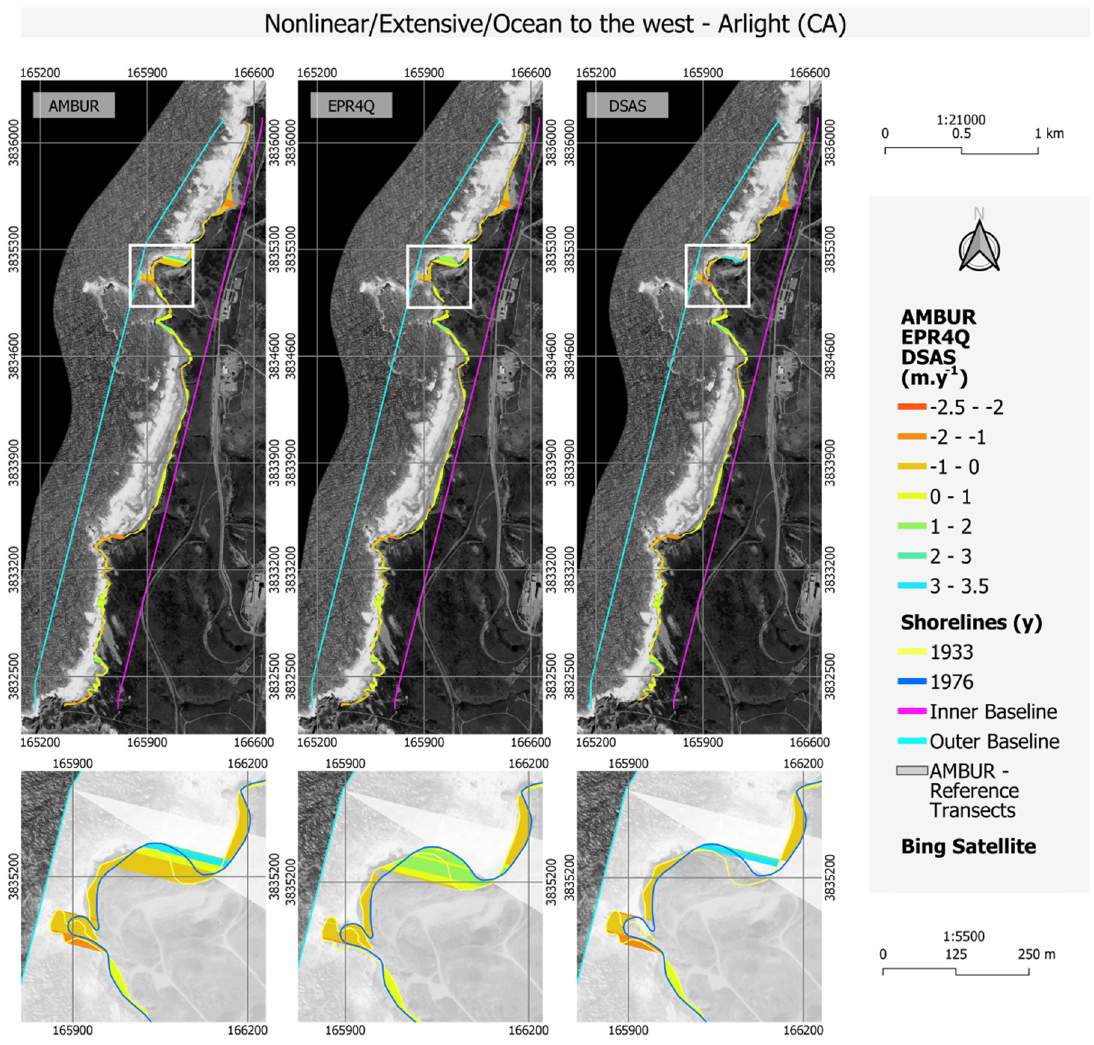
Figure 9. Shoreline changes in Arlight coast using the AMBUR, EPR4Q and DSAS tools. White box shows the details of transects in embayment configuration.